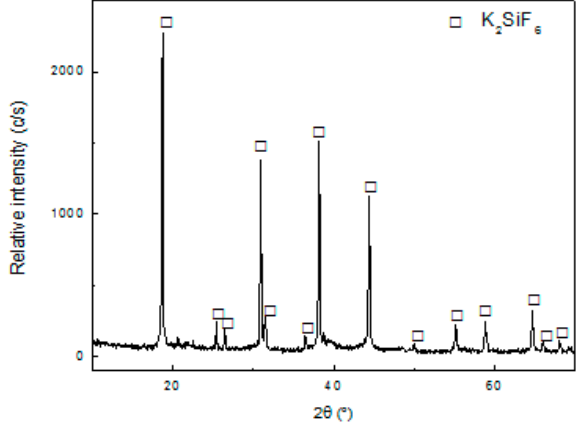
Figure 7. XRD pattern of the precipitated K 2 SiF 6 .